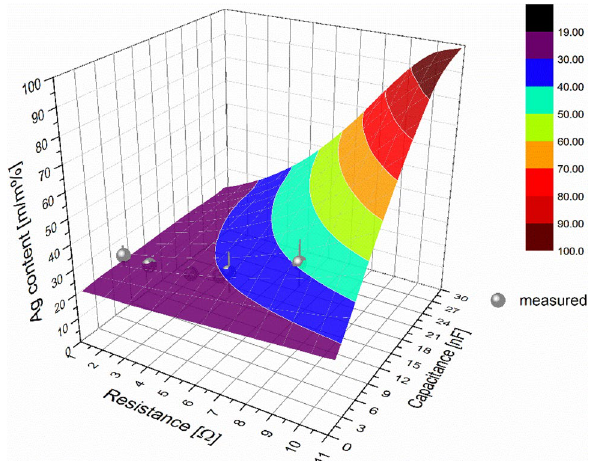
Figure 6. Theoretical Ag content of Au/Ag BNPs achievable in the SDG by varying the total resistance and capacitance of the discharge circuit (calculated from Eqs. (1) and (5). The gold electrode is initially anodic, the total inductance is 1